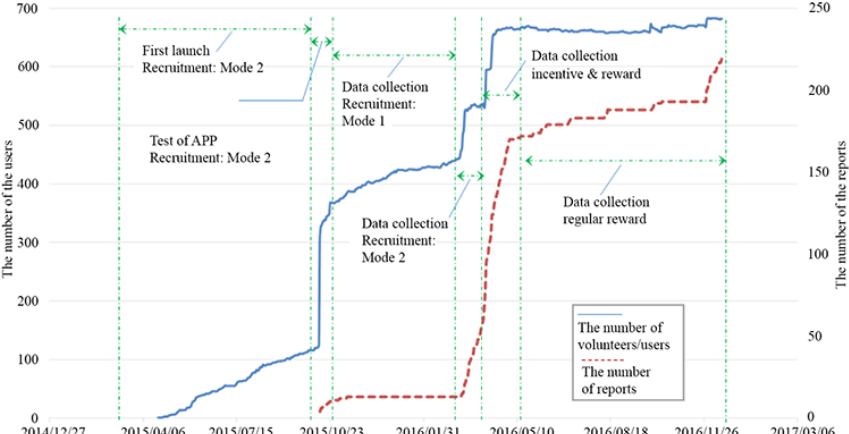
Figure 9. Increase in the number of reports and reporters.